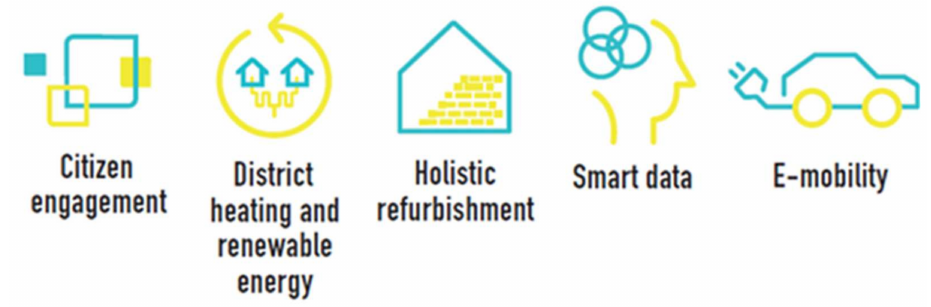
Figure 1. Clusters of co-created, smart, and integrated solutions implemented within the Smarter Together project